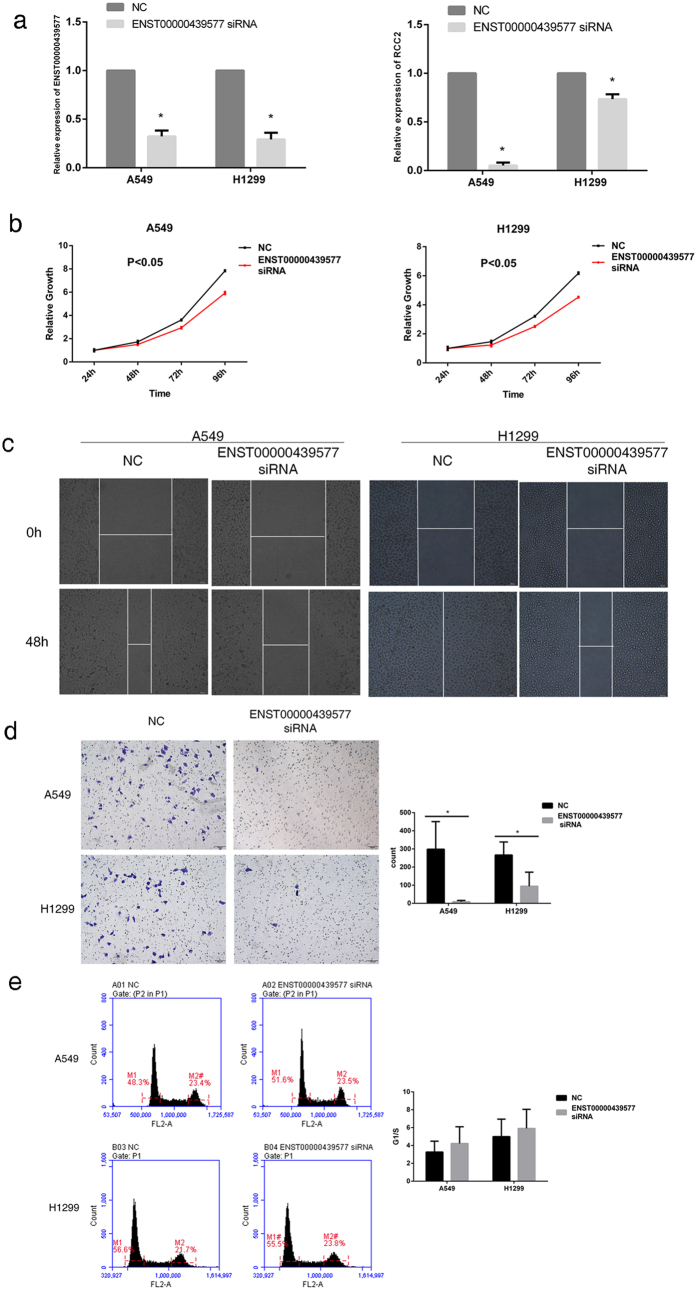
Functional analysis of ENST00000439577 expression in NSCLC cell lines A549 and H1299.(a) Declined expression of ENST00000439577 and RCC2 after siRNA-ENST00000439577 transfection. (b) Reduced A549/H1299 cell proliferation after lowering the expression of ENST00000439577. (c) Reduced A549/H1299 cell migration after lowering the expression of ENST00000439577. (d) Reduced A549/H1299 cell invasion after lowering the expression of ENST00000439577. (e) Cell cycle analysis by the C6 flow cytometry after lowering the expression of ENST00000439577. Data are expressed as mean ± s.d.; *P < 0.05. NC, Negative Control.